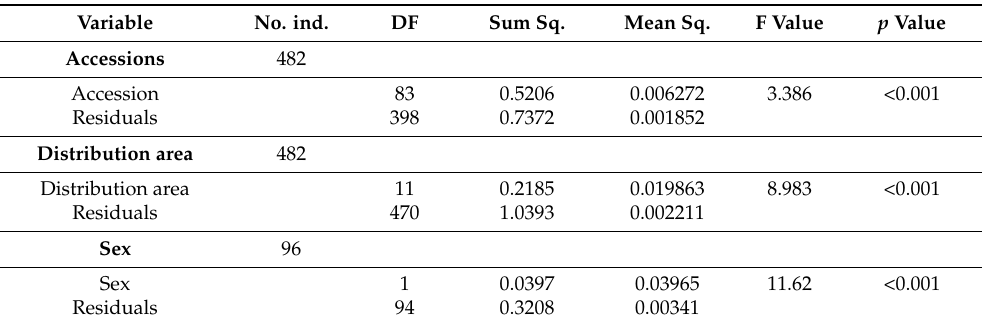
Table 1. Results of ANOVA analysis comparing the effect of accessions, distribution areas, and sex on genome size values of Cannabis .